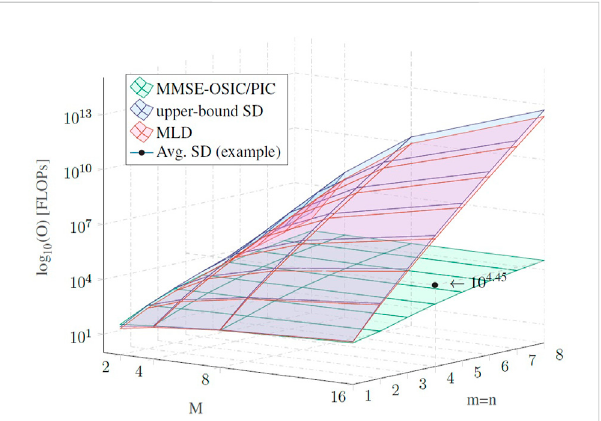
FIGURE 11 FLOP complexity comparison for the main evaluated detection methods.